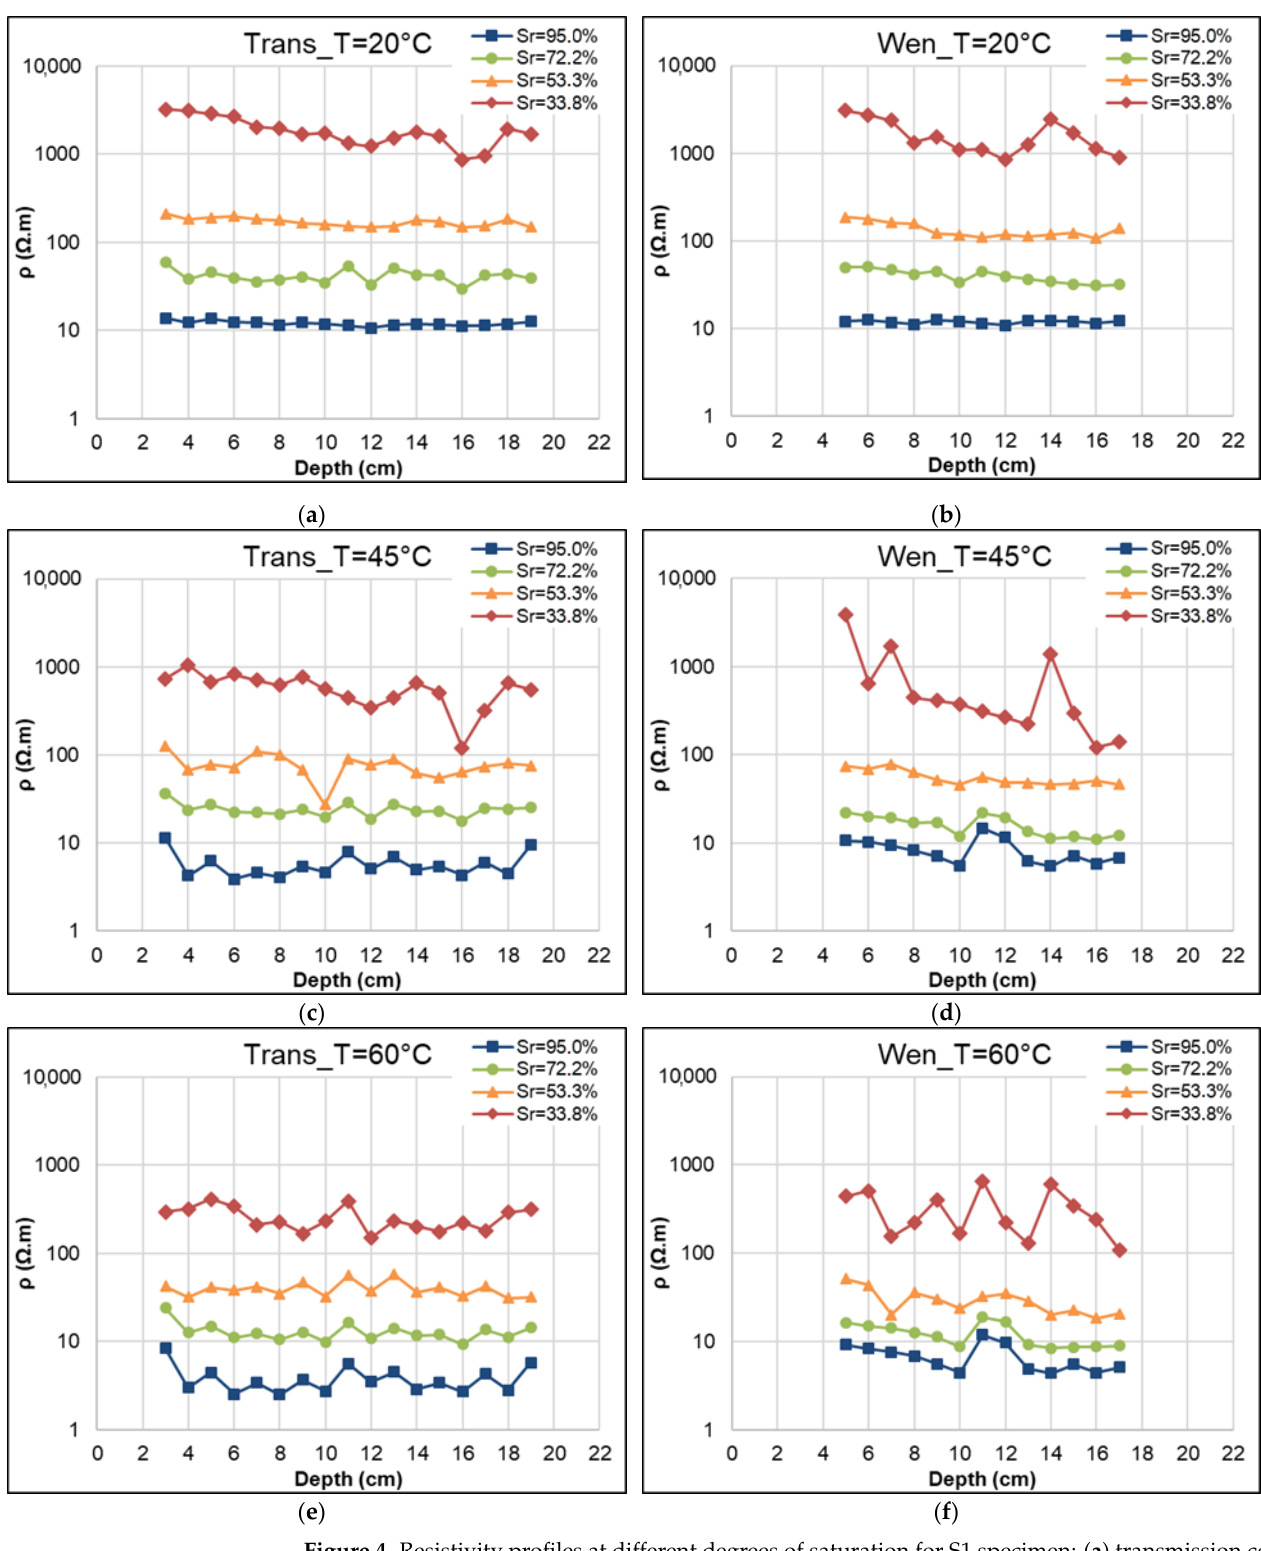
Figure 4. Resistivity profiles at different degrees of saturation for S1 specimen: ( a ) transmission con- figuration, T = 20 °C; ( b ) Wenner configuration, T = 20 °C; ( c ) transmission configuration, T = 45 °C; ( d ) Wenner configuration, T = 45 °C; ( e ) transmission configuration, T = 60 °C; ( f ) Wenner configu- ration, T = 60 °C.